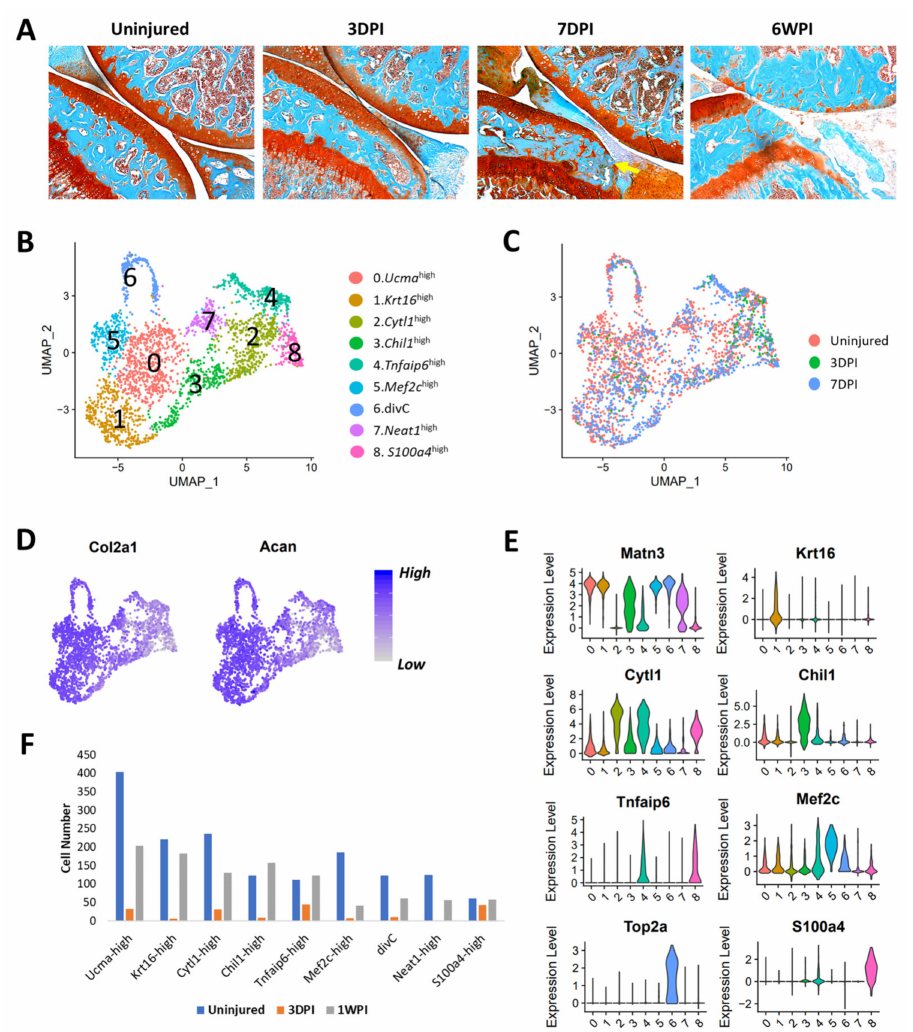
Figure 6. Injury-induced changes in chondrocytes. ( A ) Histological assessment of uninjured and injured joints at 3 days (3DPI), 7 days (7DPI), and 6 weeks (6WPI) post-injury using Safranin-O and Fast Green staining. Severe cartilage degeneration was observed at 6WPI and minor proteoglycan loss was observed at 1WPI (yellow arrow). ( B ) UMAP plots of various chondrocyte subtypes identified in uninjured, 3DPI, and 7DPI joints. Colors indicate clusters of various cell types with distinct gene expression profiles. ( C ) UMAP plots of various chondrocyte subtypes identified in uninjured, 3DPI, and 7DPI joints. Colors indicate cells from each experimental group. ( D ) Feature plots showing the expression of chondrocyte markers Col2a1 and Acan; high expression (blue), low expression (grey). ( E ) Violin plot showing the expression of chondrocyte subtype markers. ( F ) Sequenced cells per chondrocyte